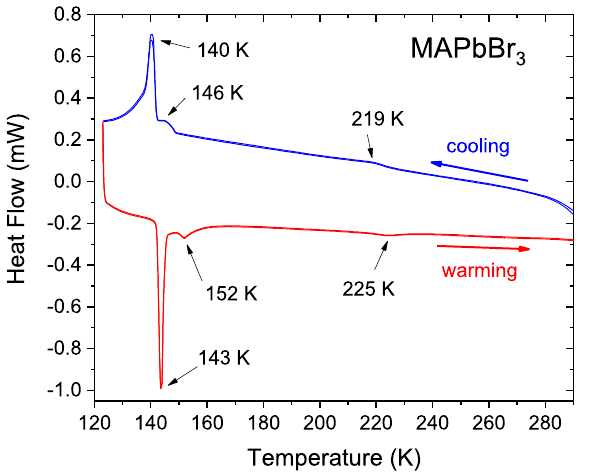
Figure 1. Warming and cooling cycles of the DSC curves of MAPbBr 3 , showing the reversible phase